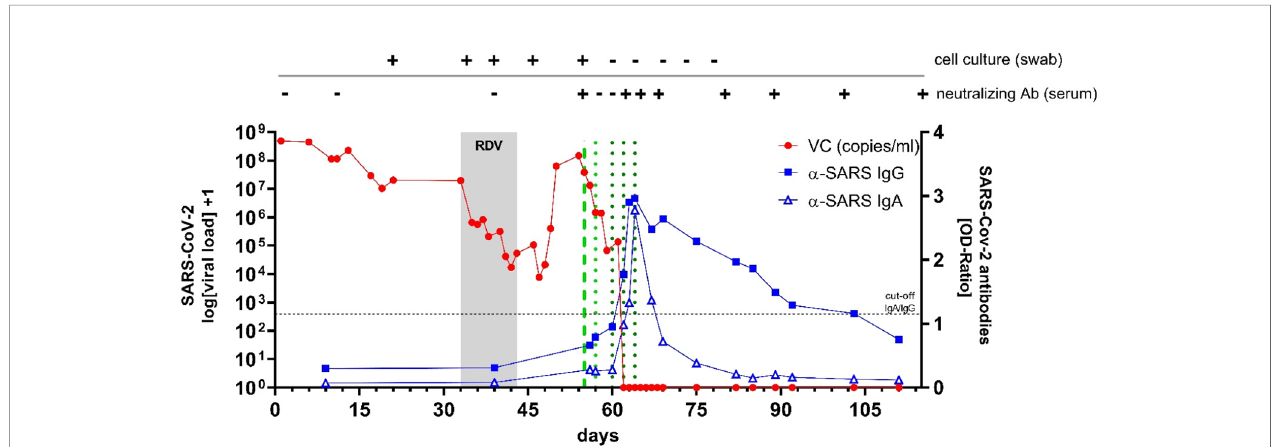
FIGURE 2 | SARS-CoV-2 viral concentration (VC) in nasopharyngeal swabs (in red) and spike speci fi c SARS-CoV-2 antibody titers over time (in blue). Cell culture was used to determine viral replication as well as presence of neutralizing antibodies (Ab). Application of remdesivir (RDV) over 10 days is depicted in grey. Application of convalescent plasma from 2 different donors is depicted as dotted green lines (light green = 3 units from donor-1; dark green = 3 units from donor-2).